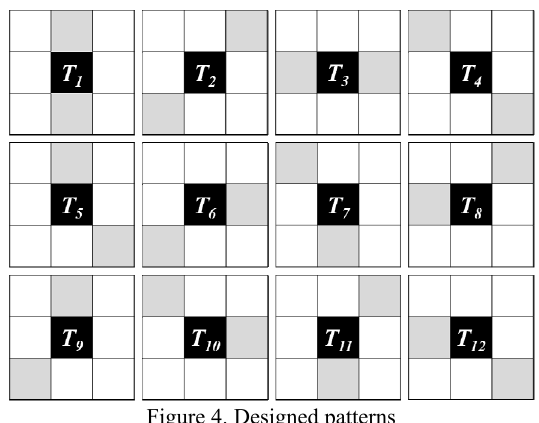
Figure 4. Designed patterns